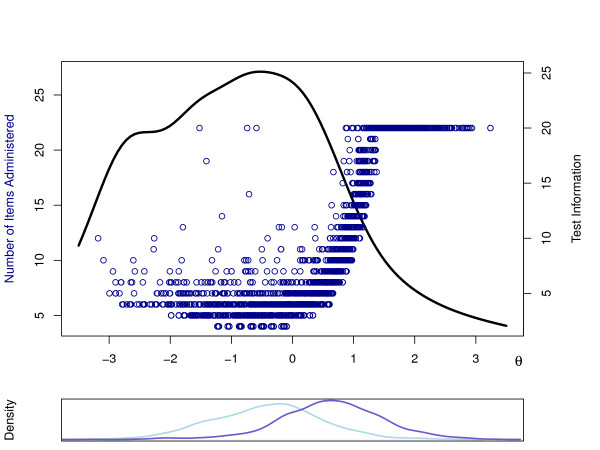
The upper panel shows the relationship between the latent depression (θ) estimate and the number of administered items for stopping rule 'SE(θ) <0.3' (blue dots represent respondents). The black curve represents test information as a function of θ. The lower panel shows the kernel density estimates of the distribution of θ in the group with (dark blue line) and without (light blue line) a depression diagnosis according to the MINI.